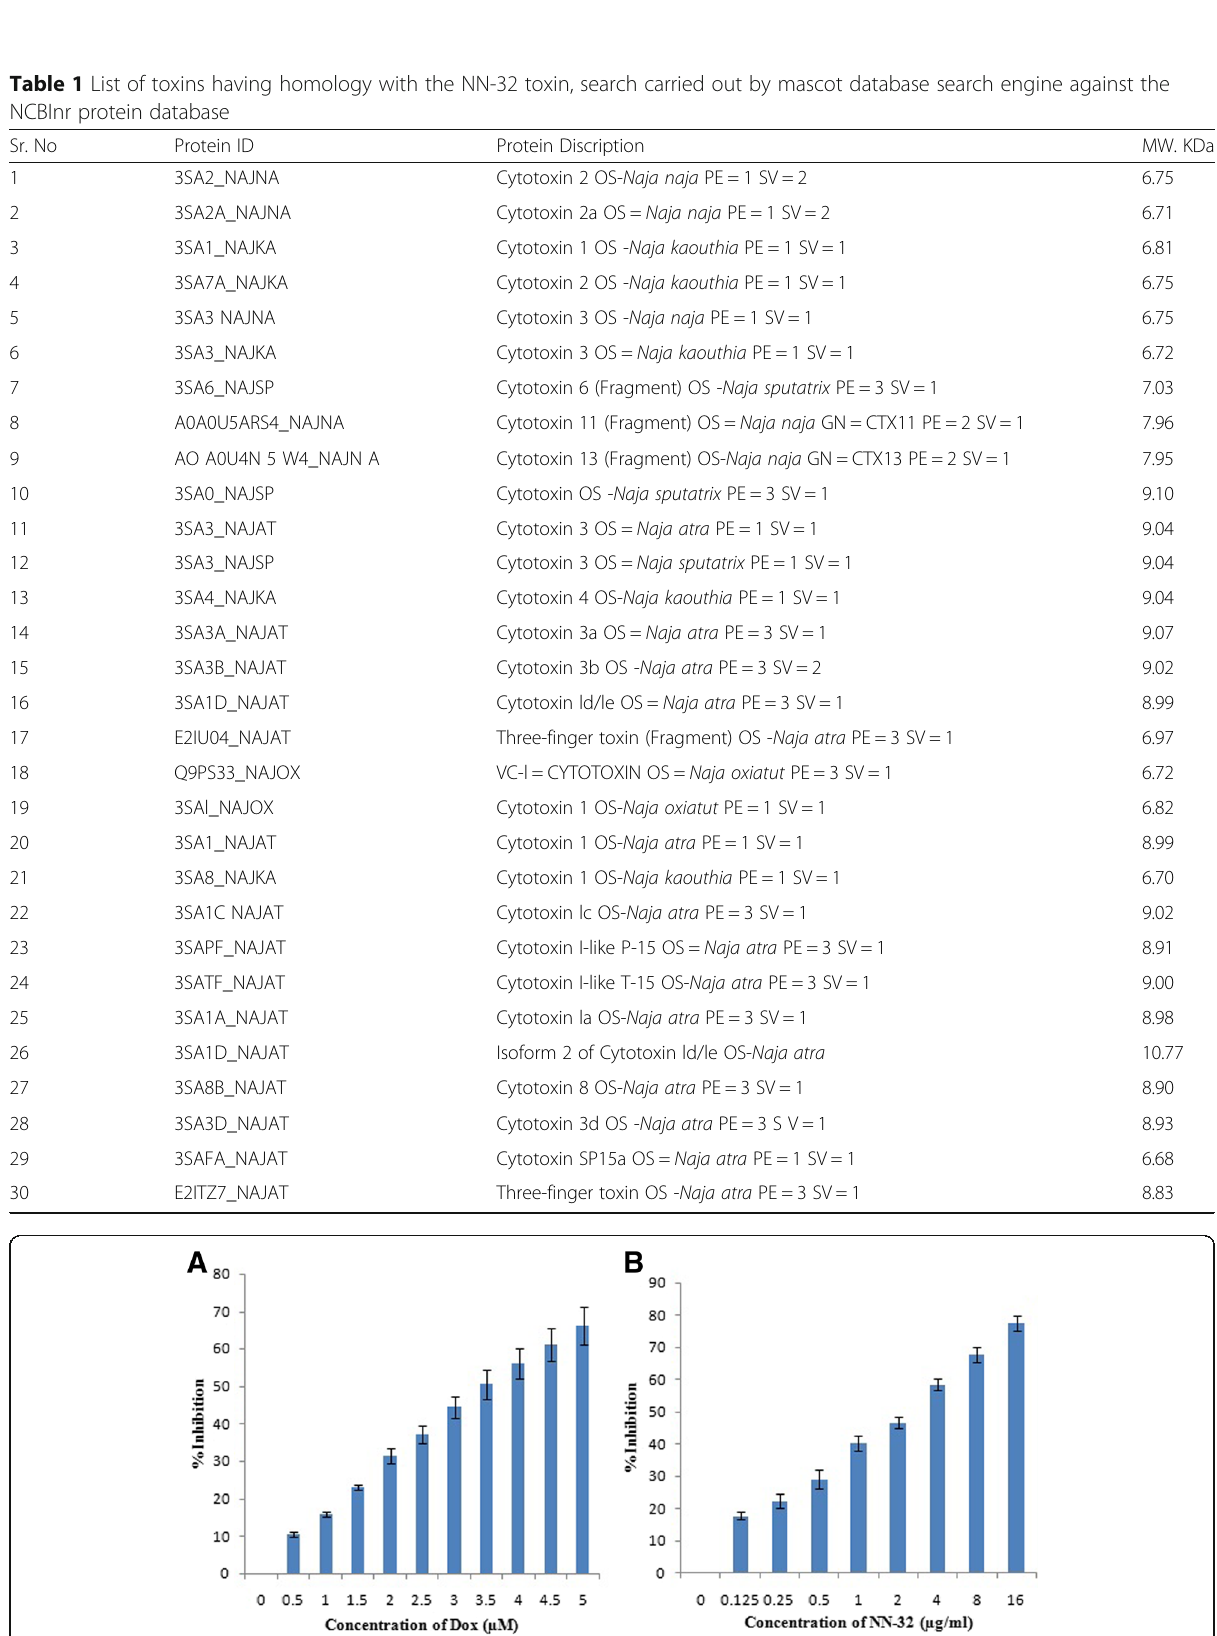
Fig. 3 Inhibition of MCF-7 cells after 48 h of treatment with ( a ) Doxorubicin and ( b ) NN-32 toxin. Values are expressed as mean ± Std. Dev ( n =